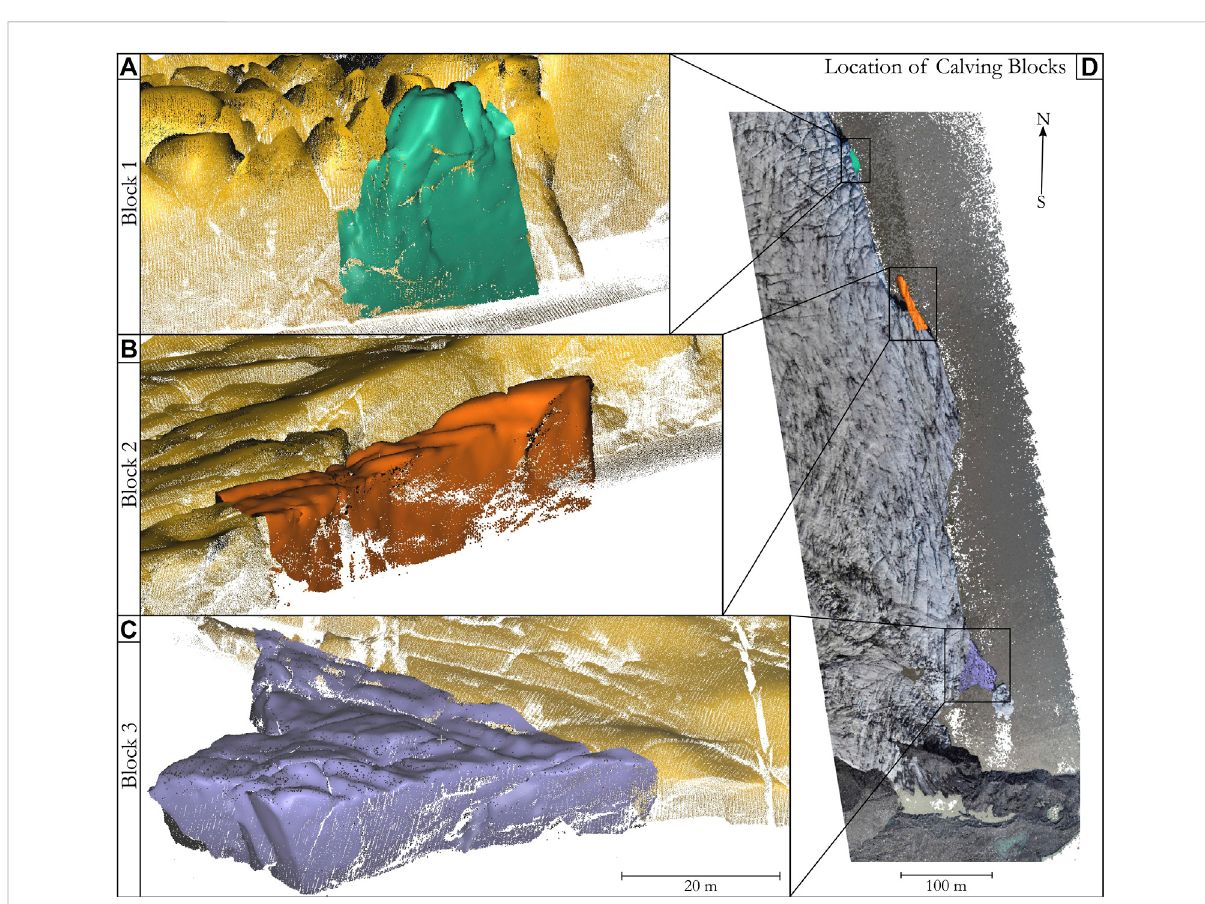
FIGURE 9 (A) Block1,atallblockoficelocatedinthedeeplycrevassednorthernregionofthestudysite, (B) Block2,athinnersectionoficeatthefrontofa series of large parallel crevasses, (C) Block 3, a shorter but larger section of ice extending out at the southern margin of the glacier, and (D) An overview of the location of calving blocks 1, 2, and 3, used in the comparison of estimating individual calving